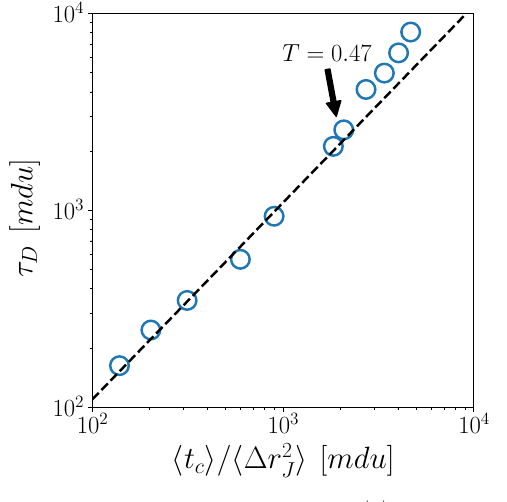
Figure 3. Scatter plot of τ D versus (cid:104) t c (cid:105) the CTRW